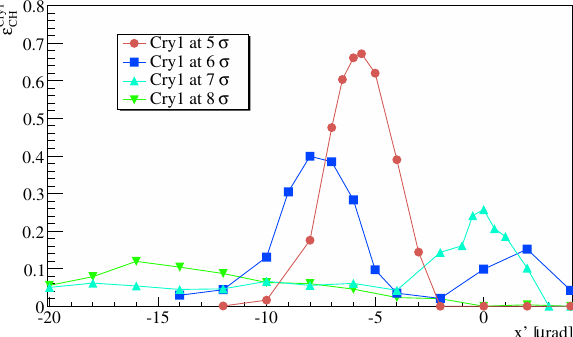
Fig. 8 Channeling efficiency as a function of the crystal orientation (in the machine reference frame) for different settings of the Cry 1 in IR3 mum channeling efficiency (defined below) was adopted to produce all the results reported here.